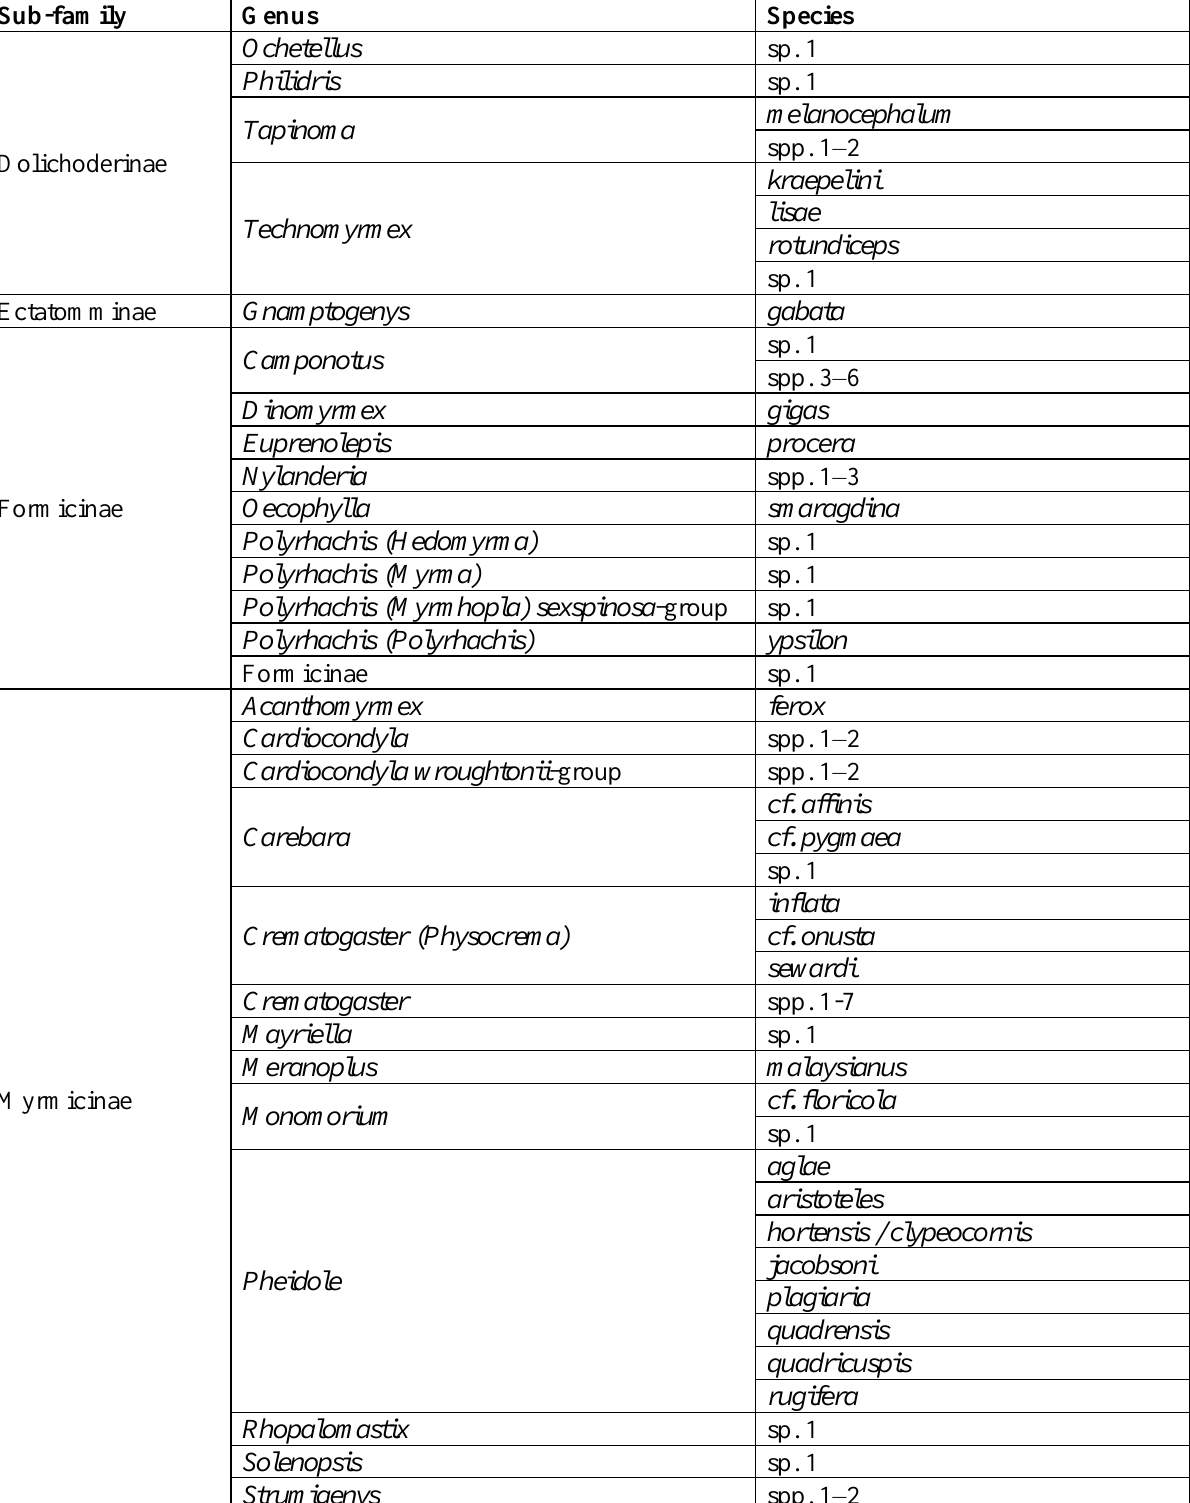
Table A2. List of ant (Formicidae) species recorded in the NLPSF, Sebangau. No species identified to species level are listed in the IUCN Red List or Indonesian protected species list. Slashes indicate cases in which identification between two species is uncertain, and parentheses indicate subgenera. Abbreviations: “nr.” = near (indicating relatedness to the taxon referred